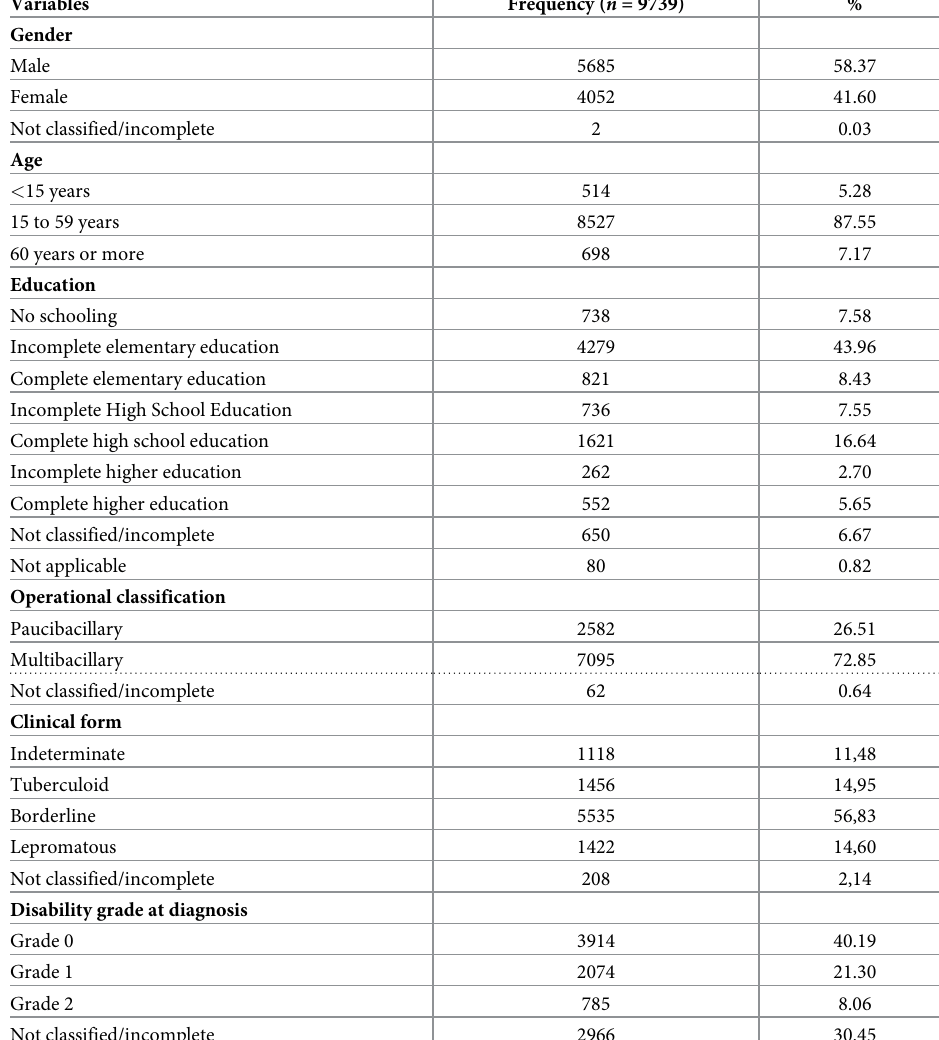
Table 2. Clinical and social epidemiological characteristics of the cases diagnosed with leprosy, in an endemic municipality in Central-West Brazil (2008–2018).